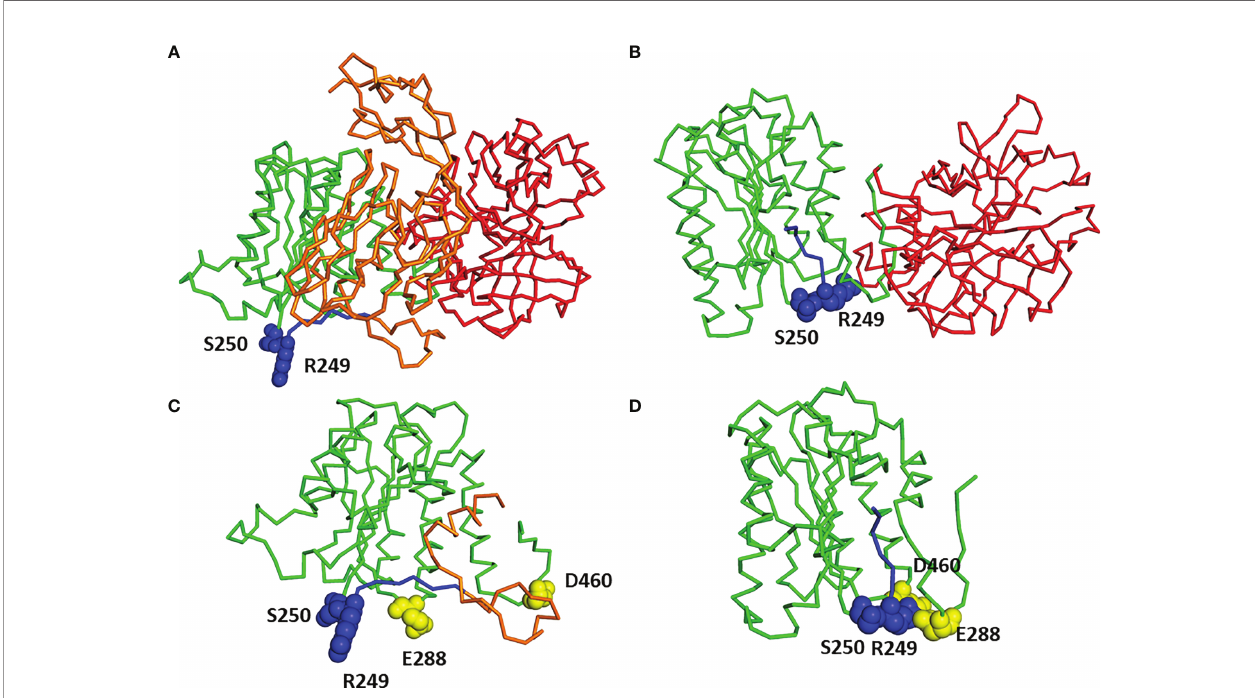
FIGURE 4 | Molecular modeling of C2 and C2b. (A) Three-dimensional model of full C2 sequence built by homology modeling using Factor B structure (PDB code 2XWB) as a template. C2b domain in orange, VWA domain in green, SP domain in red, residues 243 – 250 in blue, and residues 249 and 250 in spheres representation. (B) Three-dimensional structure of C2a (PDB code 2I6Q). VWA domain in green, SP domain in red, residues 243 – 250 in blue, and residues 249 and 250 in spheres representation. (C) Close-up view of VWA domain and part of domain C2b from the complete structure of C2 protein [see (A) ], color code as used in (A) , moreover residues 288 and 460 are shown in yellow. (D) Close-up view of VWA domain from C2a structure [see (B) ] with residues 288 and 460 shown in